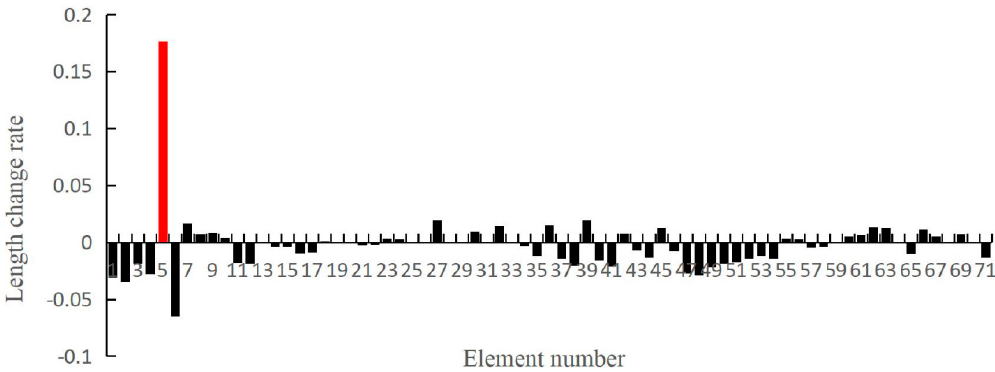
Figure 6. Length change rate of element obtained from the static data (element 5 was damaged with an added 5% noise).